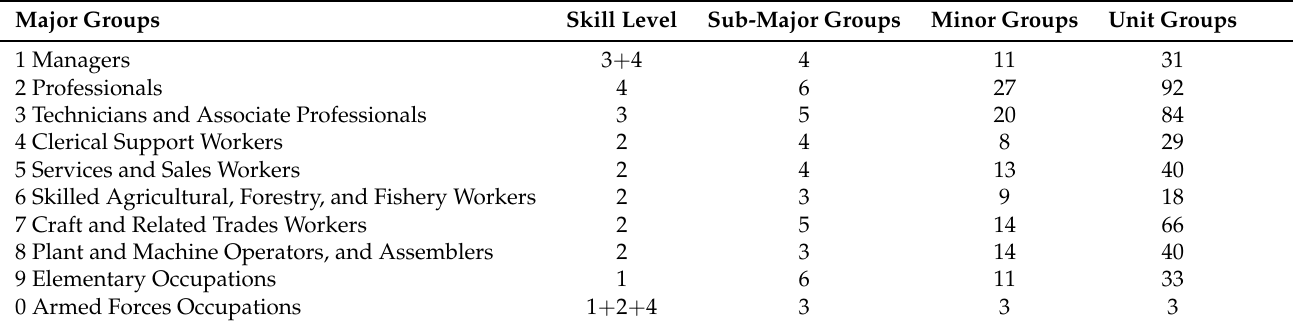
Table 2. Major occupation groups and skill Level as classified by ISCO-08